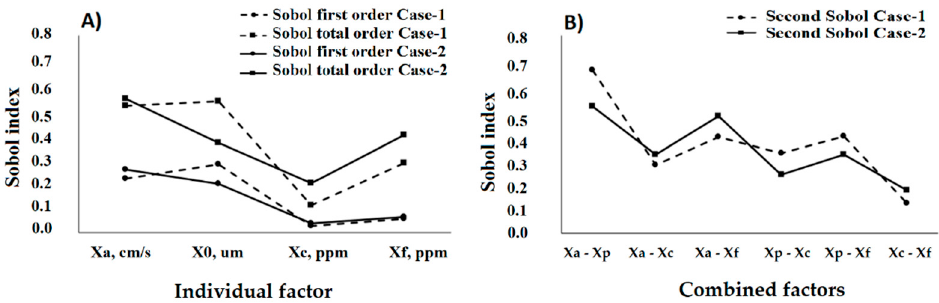
Figure 4. Global sensitivity analysis for copper recoveries in Case 1 and Case 2: ( A ) first and total index and ( B ) second-order index.